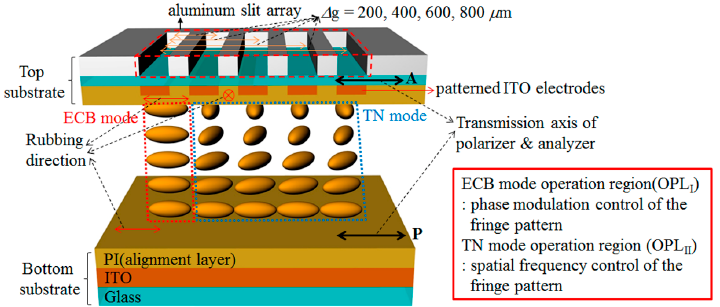
Figure 1. Schematic of the LC-based dynamic fringe pattern generator for projecting multiple sets of interference patterns with phase-shifting and spatial-frequency-varying properties.